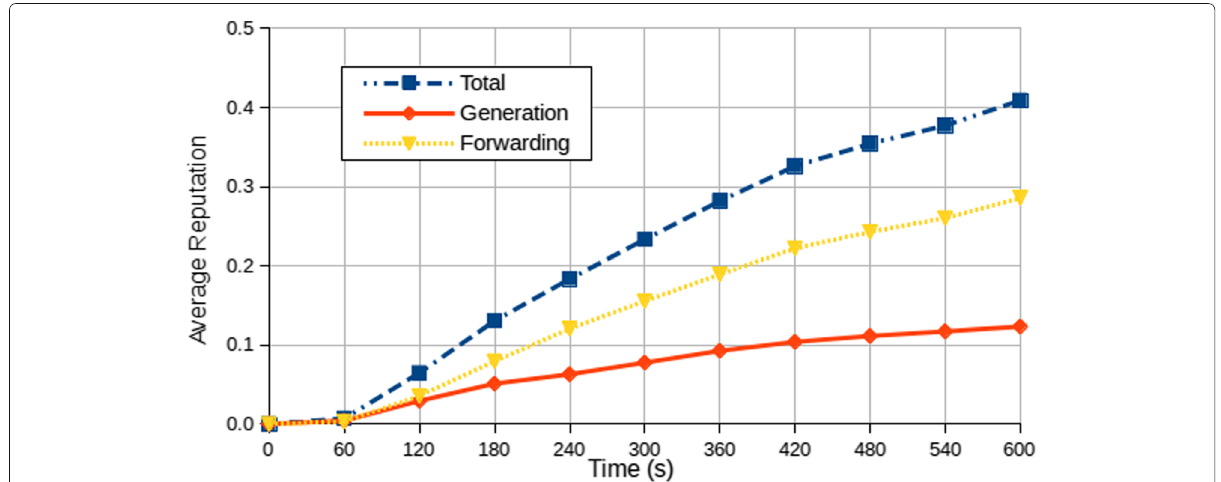
Fig. 7 Results of AR with MV = 12.5%